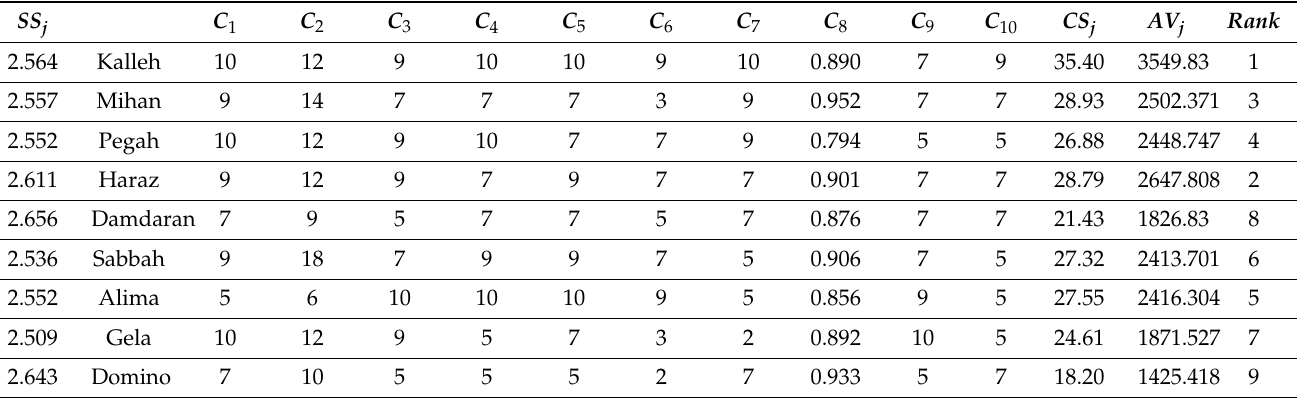
Table 7. Ranking of the cheese